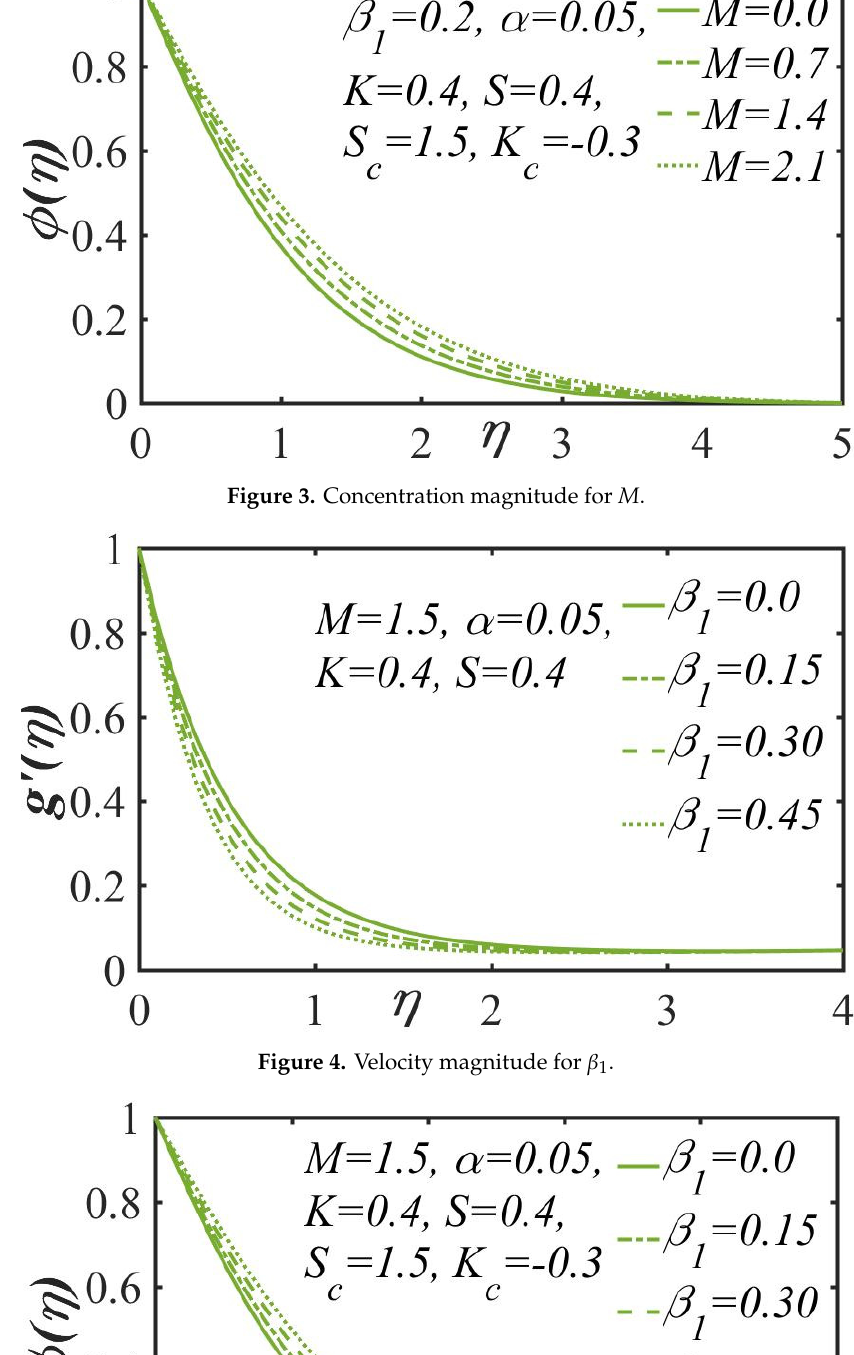
Figure 4. Velocity magnitude for (cid:2010) (cid:2869) .